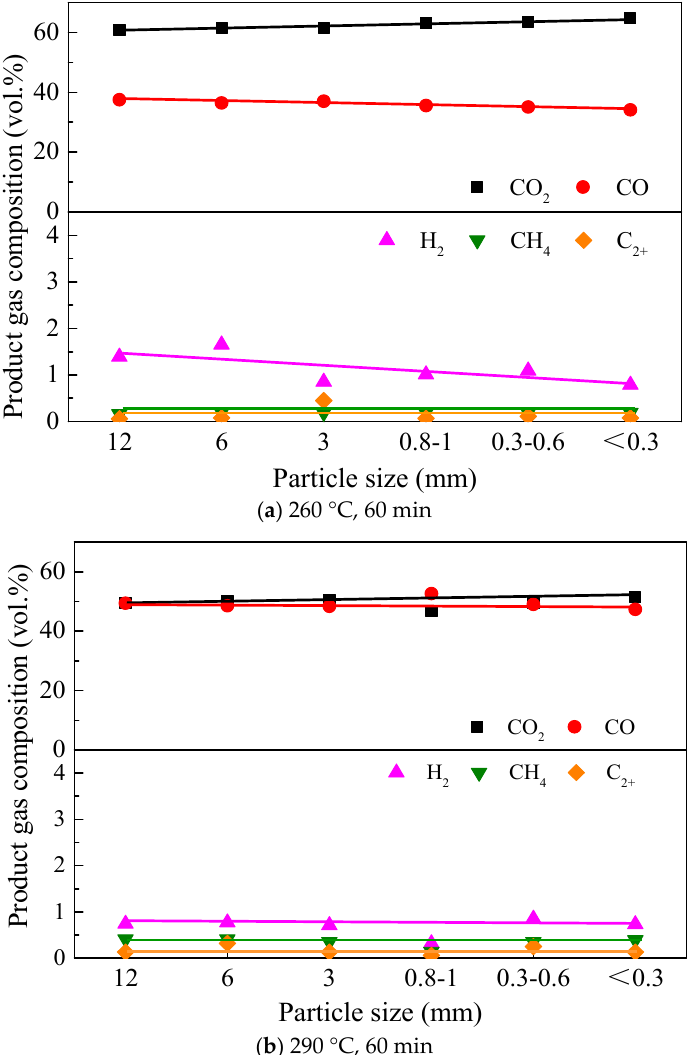
Figure 3. Effect of particle size on the product gas composition of Paulownia wood torrefaction under different temperatures.